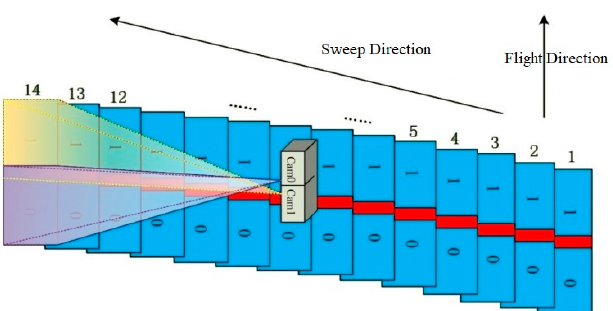
Figure 2. Dual Lenses of VisionMap A3.